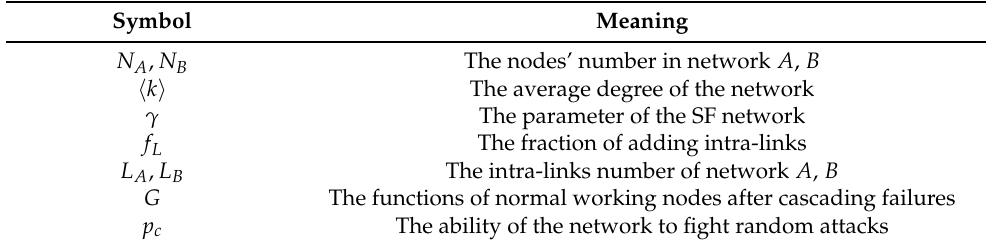
Table 3. Notations of parameters and